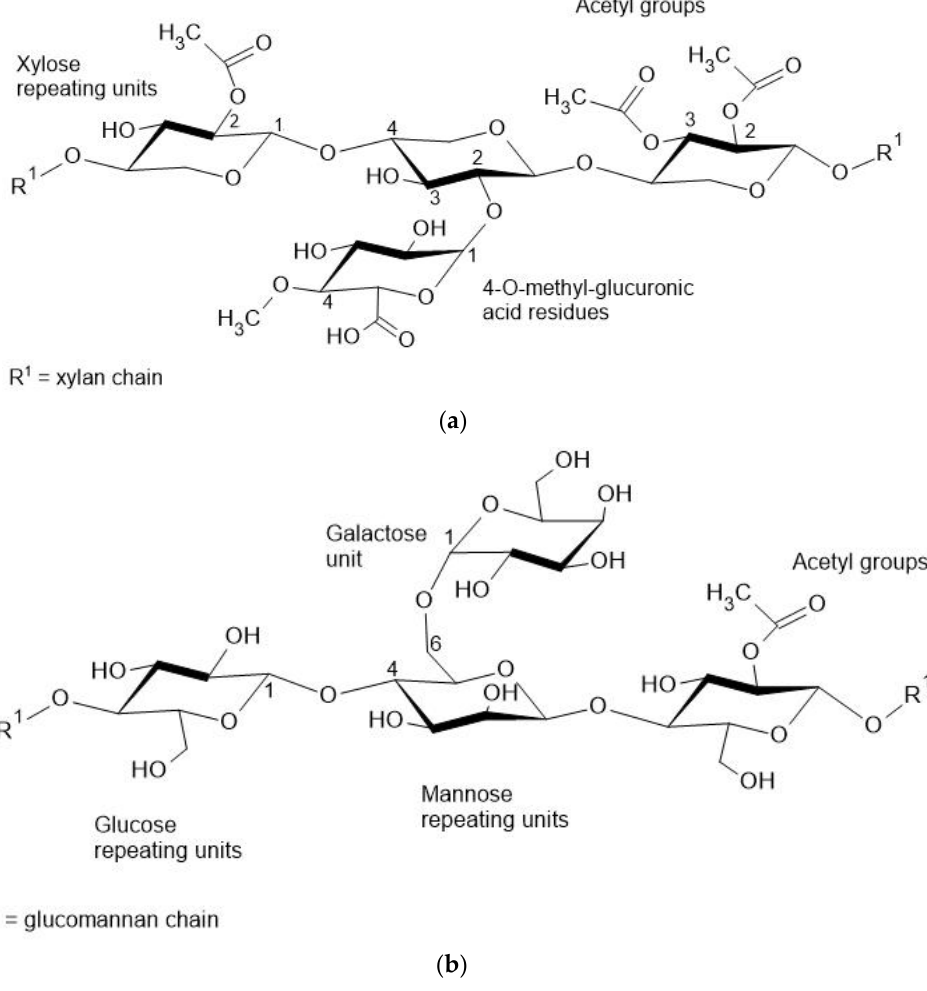
Figure 7. Representation of hemicellulose constituents( a ) O-acetyl-4-O-methylglucoronoxylan, ( b ) O–acetylgalactoglucomannan. Citric acid was used as a crosslinking agent in xylan-based bioplastics blend with polyvinyl alcohol [49]. A strong link between the filmogenic matrices was observed due to the formation of ester bonds between the molecules and hydrogen bonds. The bioplastic elongation increased from 15.1% to 249.5%; however, the tensile strength was reduced when citric acid acted as a